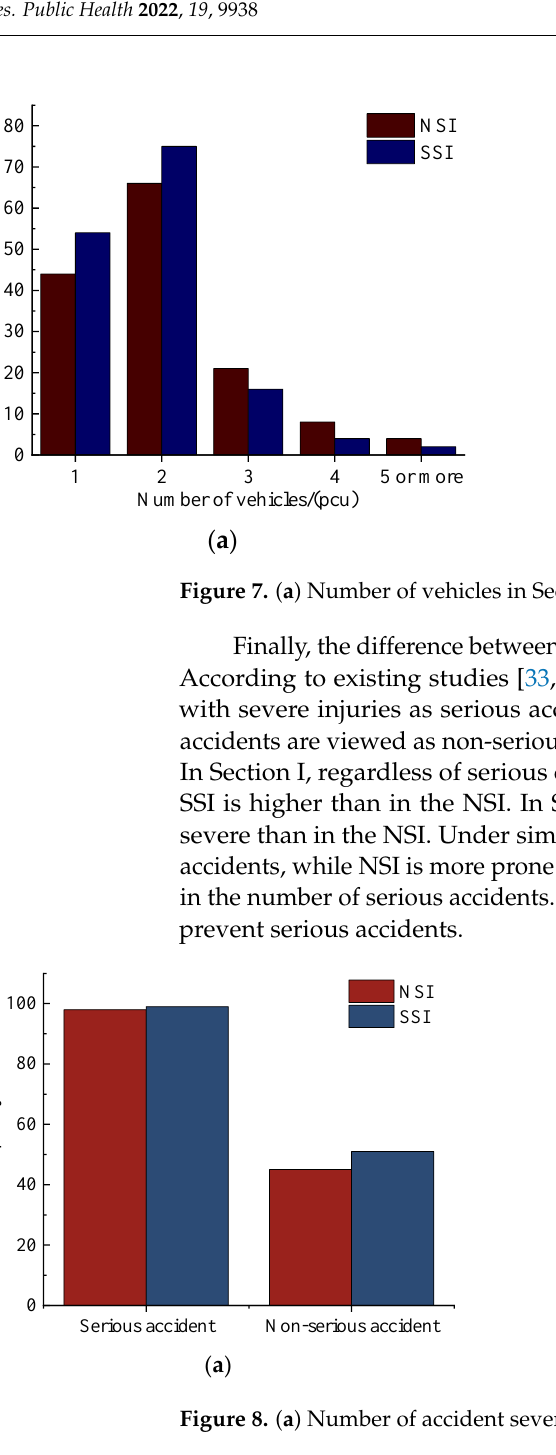
Figure 8. ( a ) Number of accident severity in Section Ⅰ ; ( b ) Number of accident severity in Section Ⅱ . In general, SSI and NSI have some similarities and differences. They all belong to the interchange, so there is a certain similarity in the type of accident. For example, rear-end collisions are the main types of accidents, and multi-vehicle accidents are the main accidents. Simultaneously, there are some differences between the two interchange types. For example, more collisions with fixed objects occurred in the SSI, and two-vehicle accidents are the primary accidents. The above findings can provide some support for traffic safety